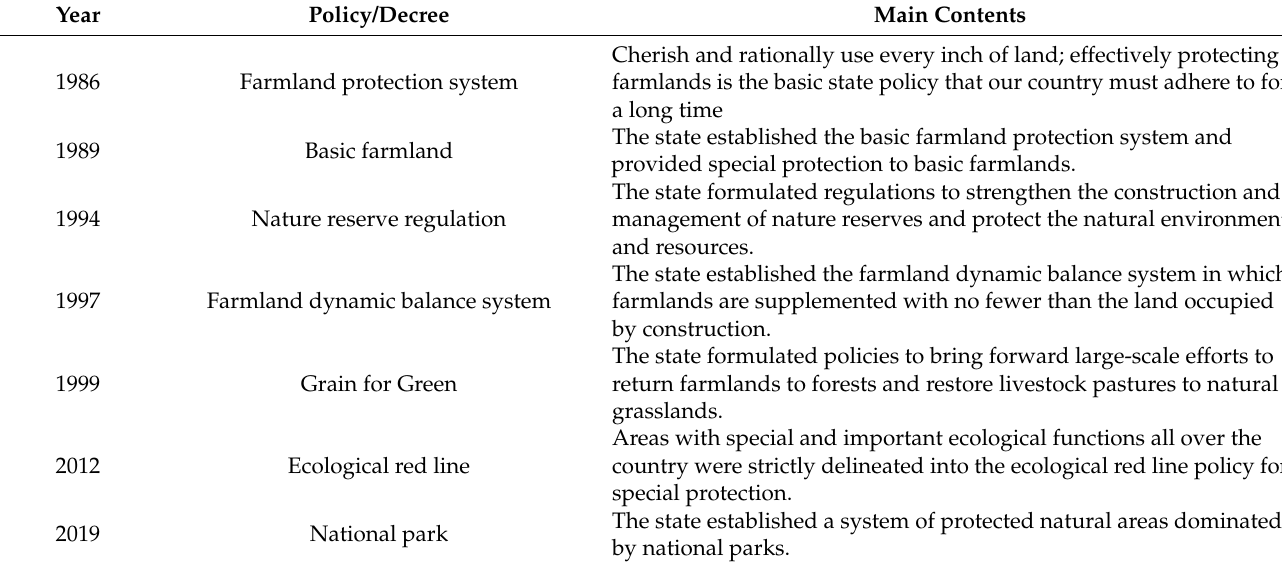
Table 9. Major governmental policies that influence the land use conflict of the territorial space in China from the 1980s to